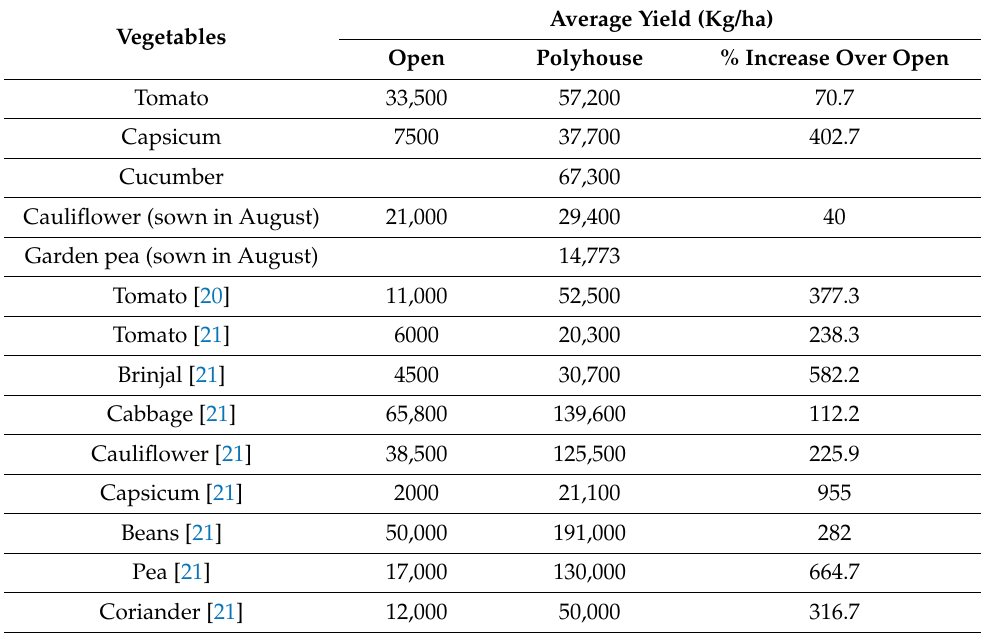
Table A1. Crop yield in open field and protected cultivation in Uttarakhand.